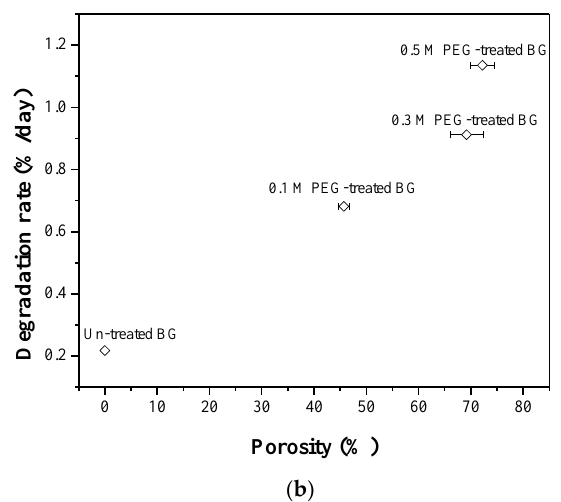
Figure 10. Correlations of ( a ) porosity to PEG concentration and ( b ) degradation rate to porosity.